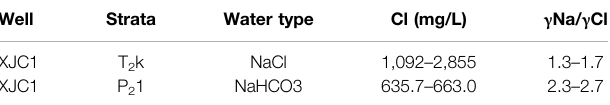
TABLE 1 | Chemical characteristics of fl owback water in the T 2 k and P 2 l